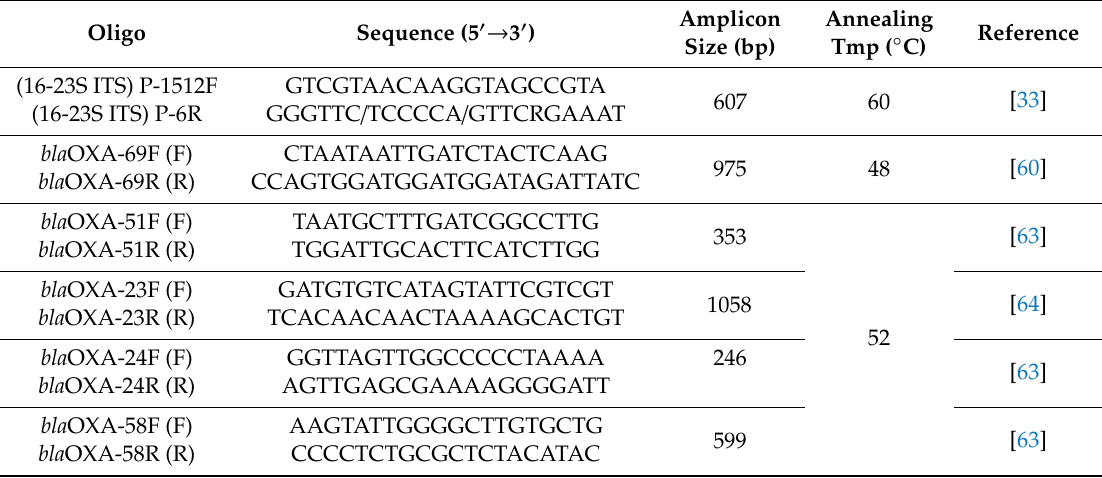
Table 4. Sequence, amplicon size and annealing temperature of oligos used in the study.